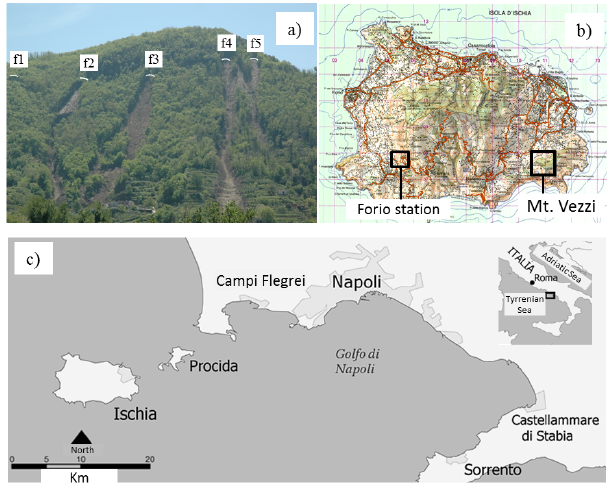
Figure 1. (a) Northern slope of Mt. Vezzi, showing both the posi- tions and names (by Ascione et al., 2007) of the five head scarps; (b) topographic map of Ischia (1 : 50000 scale), showing the loca- tions of Mt. Vezzi and the Forio station, (c) location of the island of Ischia ahead of the Golfo di Napoli (southern